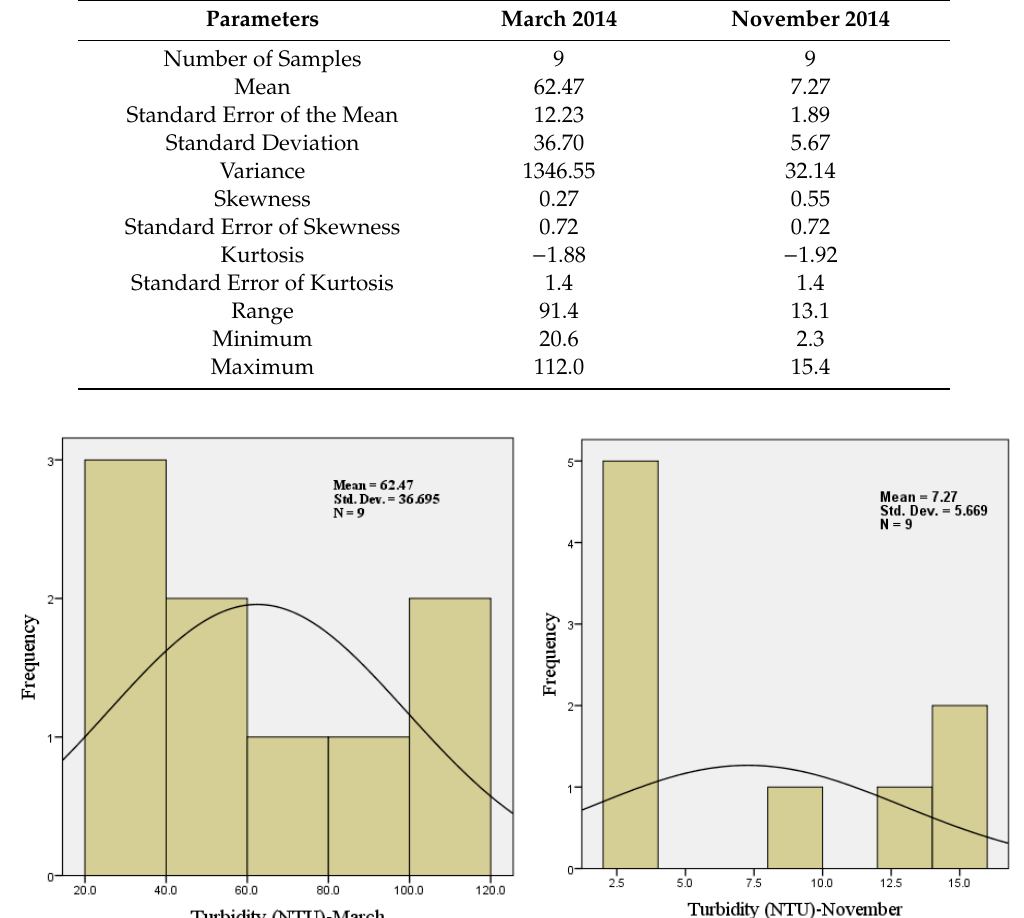
Figure 3. Frequency graphs showing the turbidity distribution on 13 March ( left ) and 27 November 2014 ( right ).